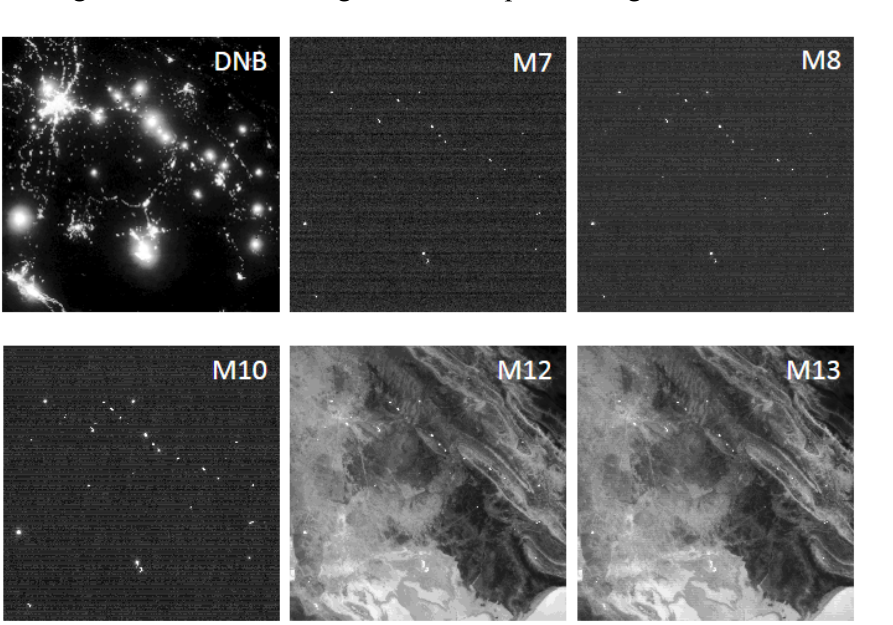
Figure 2. Sample images of Southern Iraq from the nine VIIRS spectral bands which collect data at night. The area has a large number of persistent gas